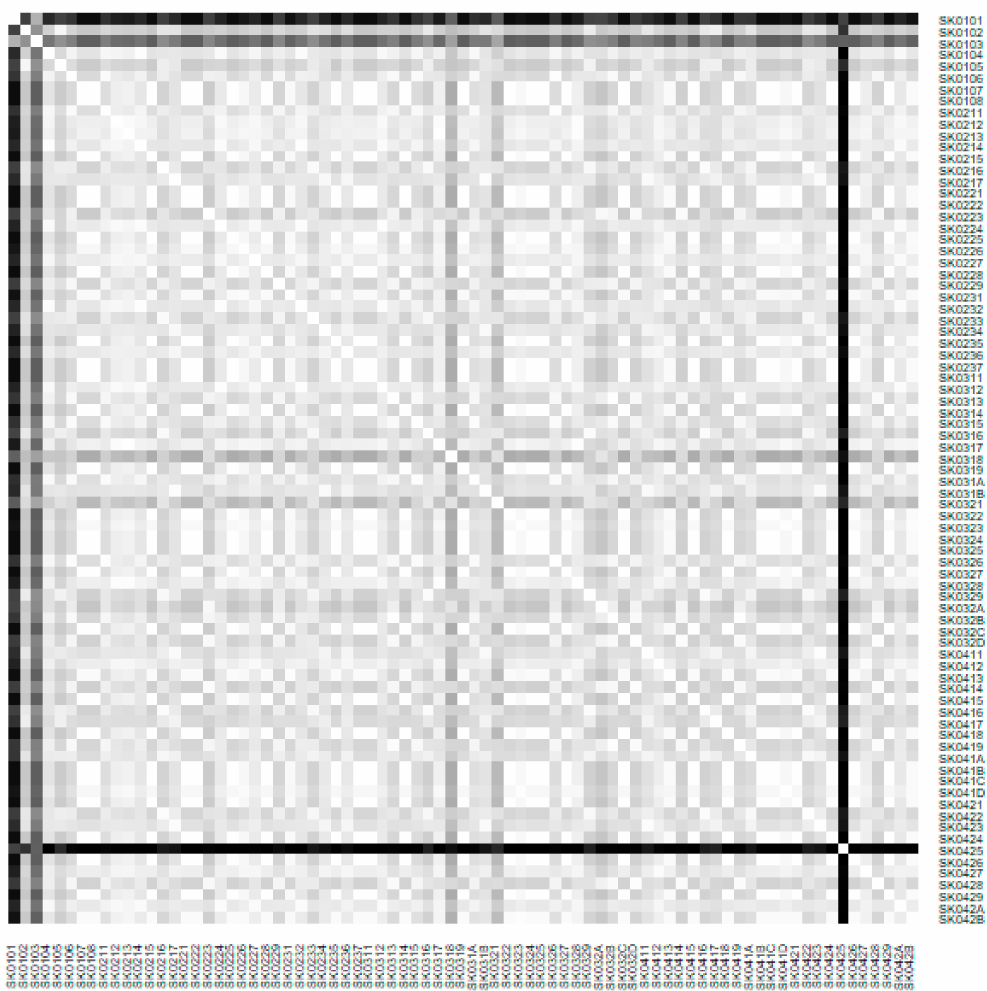
Figure 6. Medical equipment heat map of the districts in the whole explored period. Source: own elaboration by the